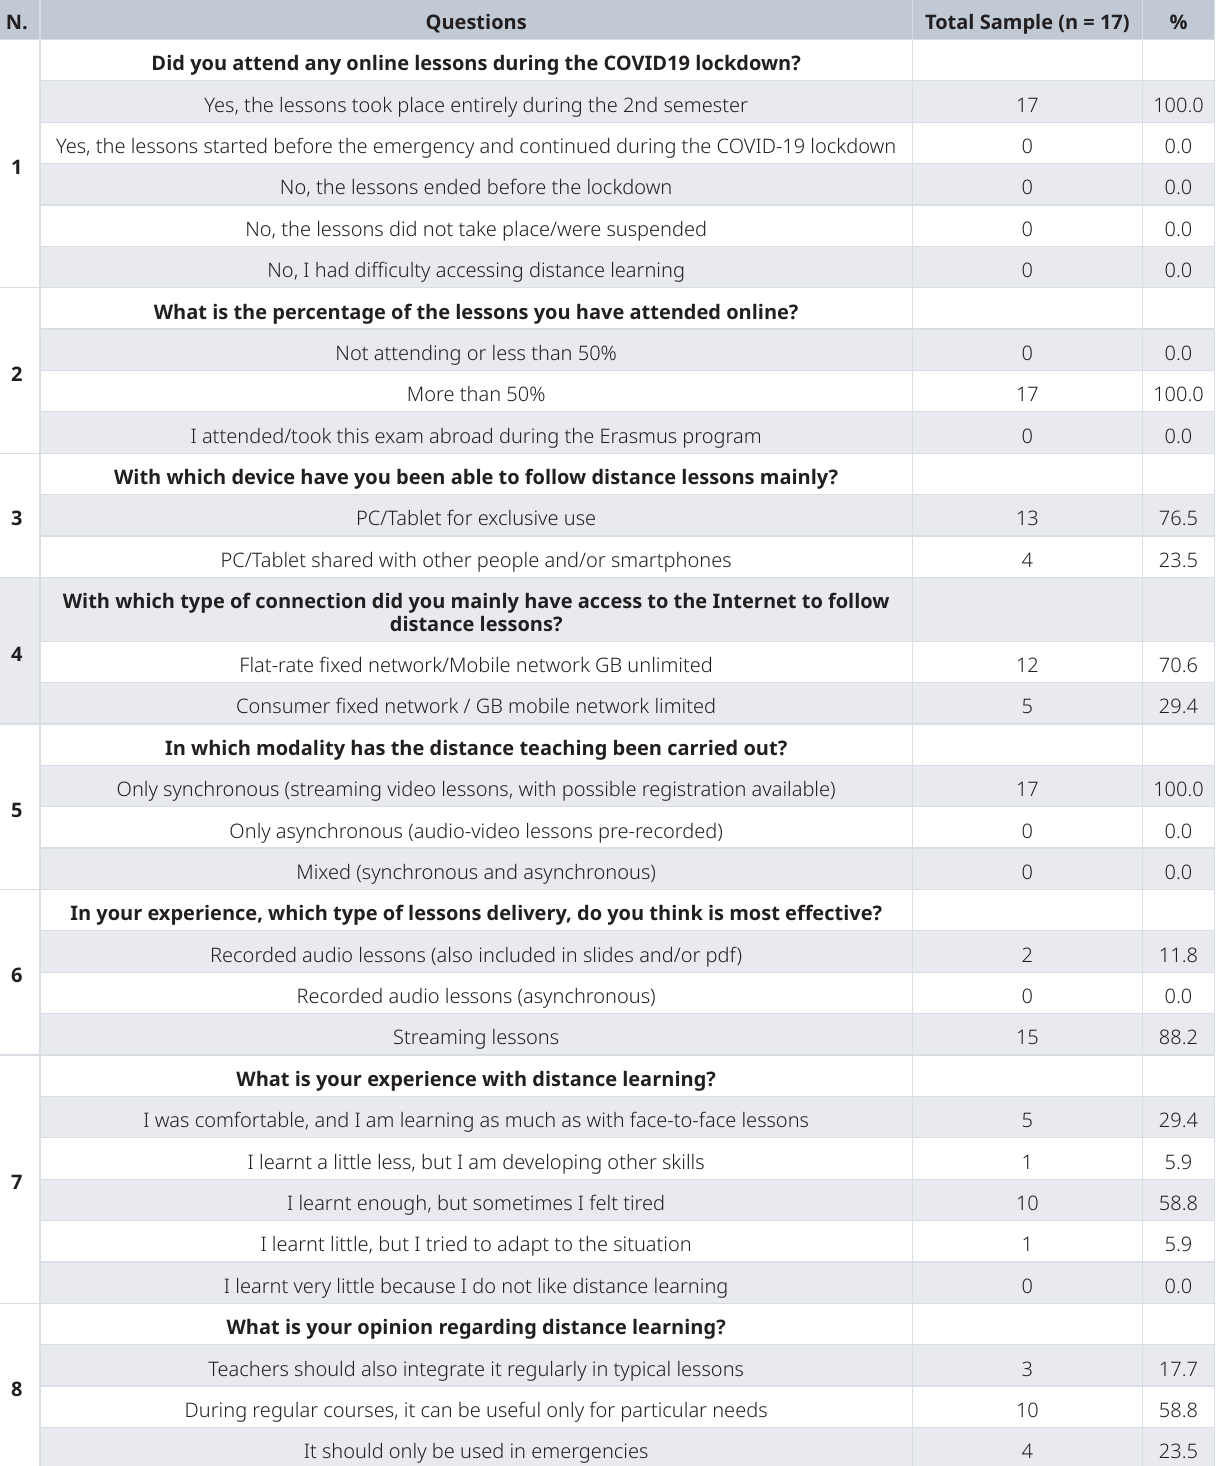
Table 2. Distance learning during lockdown.